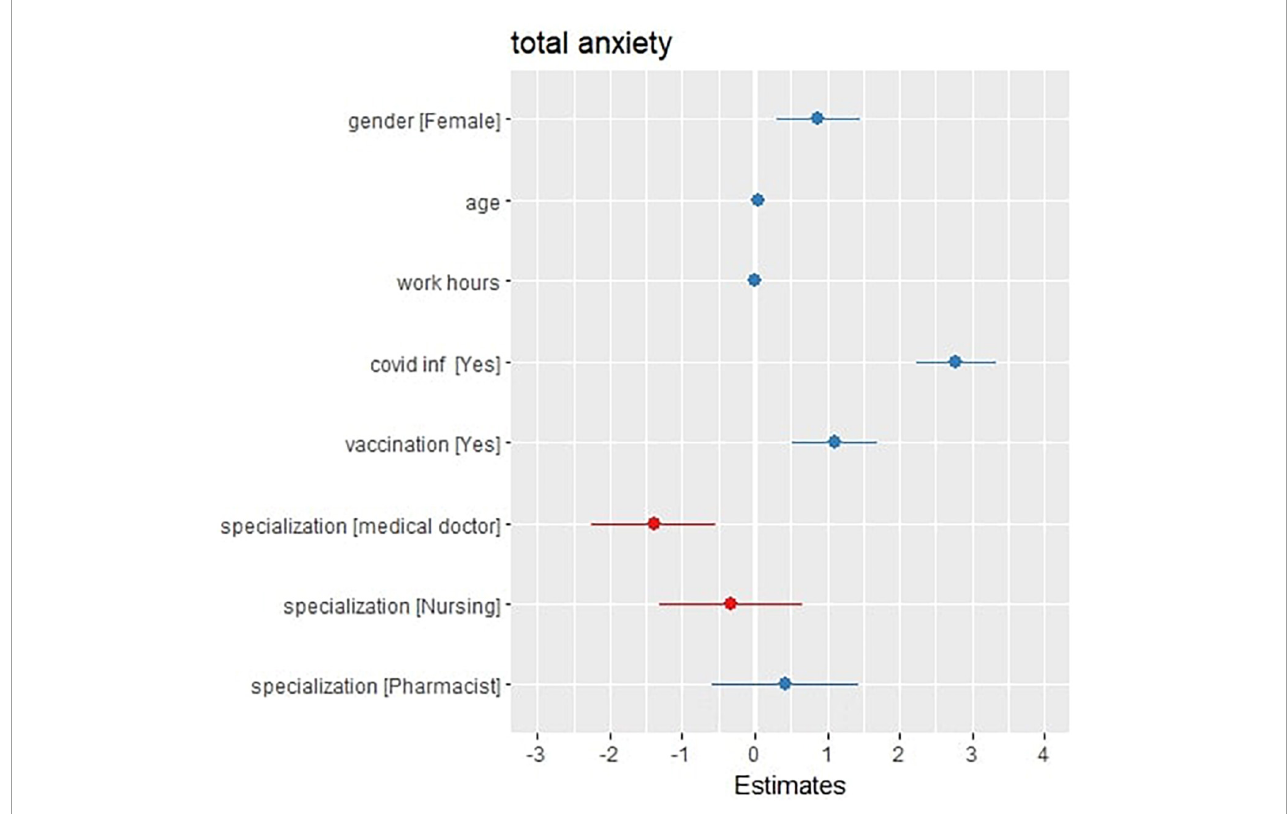
FIGURE2 Forest (dot whisker) plot of the anxiety generalized non-linear regression model (shows the positions and direction of significance).